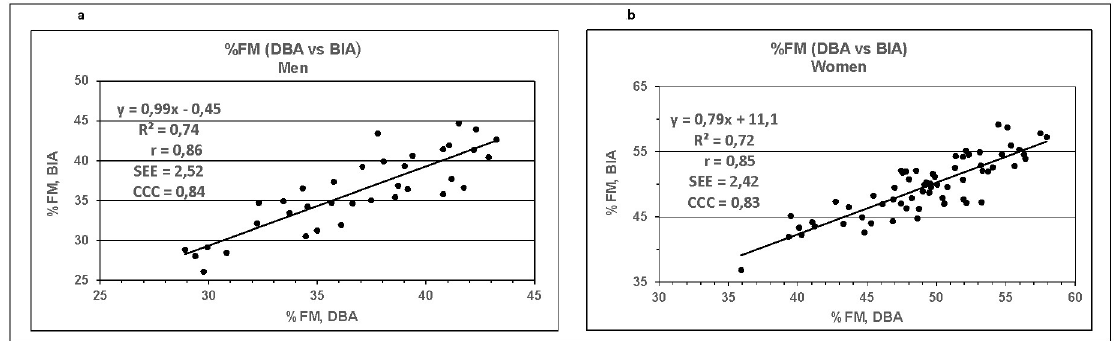
system: r = 0.88 for men (Fig 1a) and r = 0.70 for women (Fig 1b). The results obtained from BIA are: r = 0.76 for men (Fig 1c) and r = 0.66 for women (Fig 1d). The analysis of %FM data assessed by the DBA and BIA method were compared by regres- sion analysis and results are plotted in Fig 2a and 2b. The determination coefficient R 2 and the standard error of estimate (SEE) are 0.74 (2.52) for men (Fig 2a) and 0.72 (2.42) for women (Fig 2b). Lin’s concordance correlation coefficients (CCC) revealed the following results: CCC = 0.84 for men and CCC = 0.83 for women, respec- tively and underline the strong concordance between the two data sets. Analysis according to the Bland-Altman method was created to determine absolute agree- ment between the %FM assessed by DBA and BIA system. The limits of agreement between